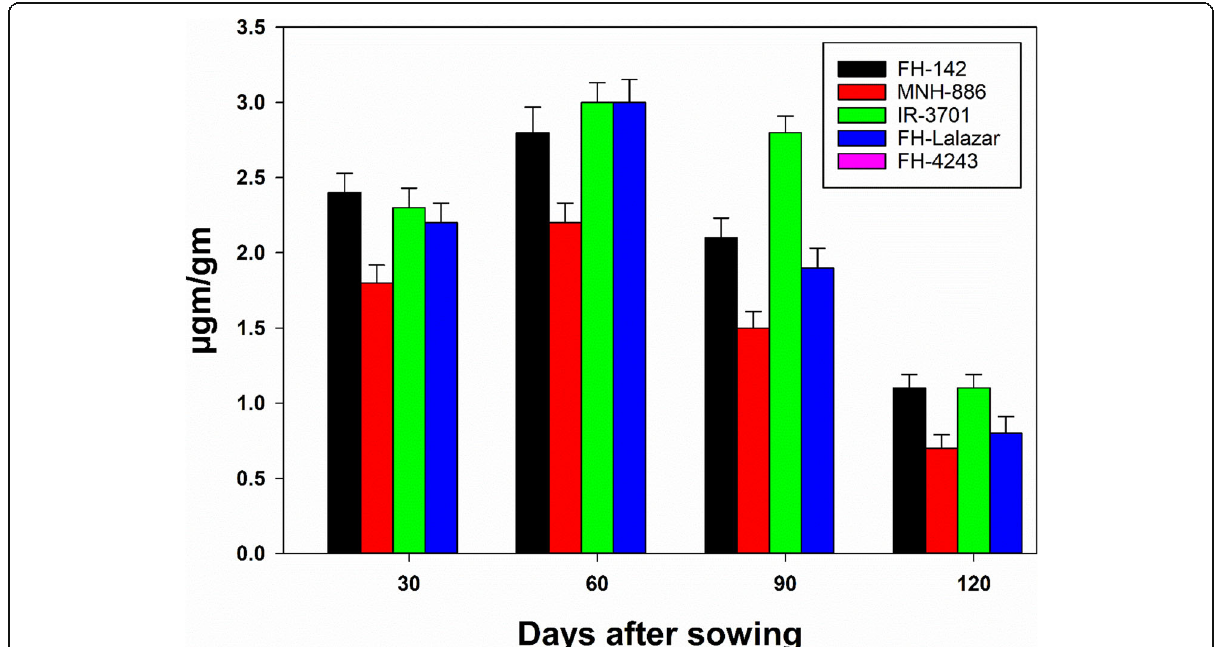
Fig. 2 Bacillus thuringiensis expression of Cry1Ac ( μ g/g of fresh wt.) in different cultivars of cotton at different crop stages and time